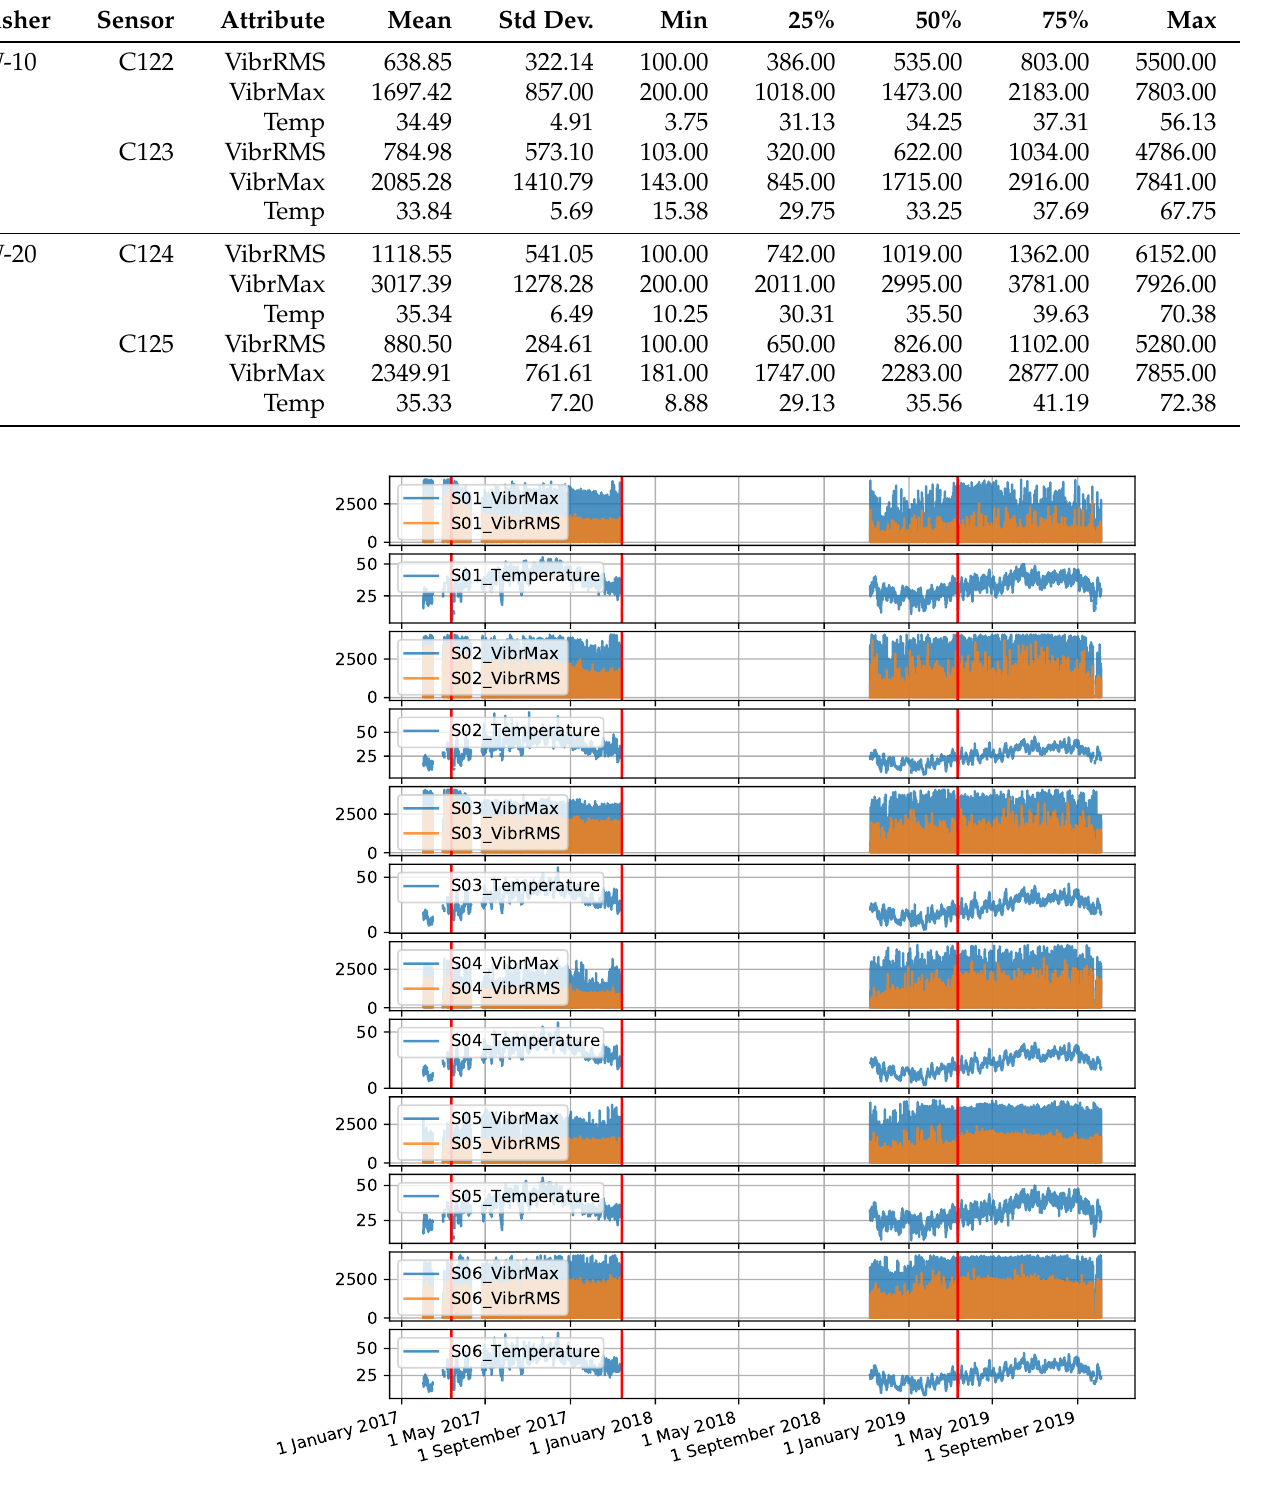
Figure A4. Time series for the S201 gantry collected by six sensors (the red colour indicates the locations of